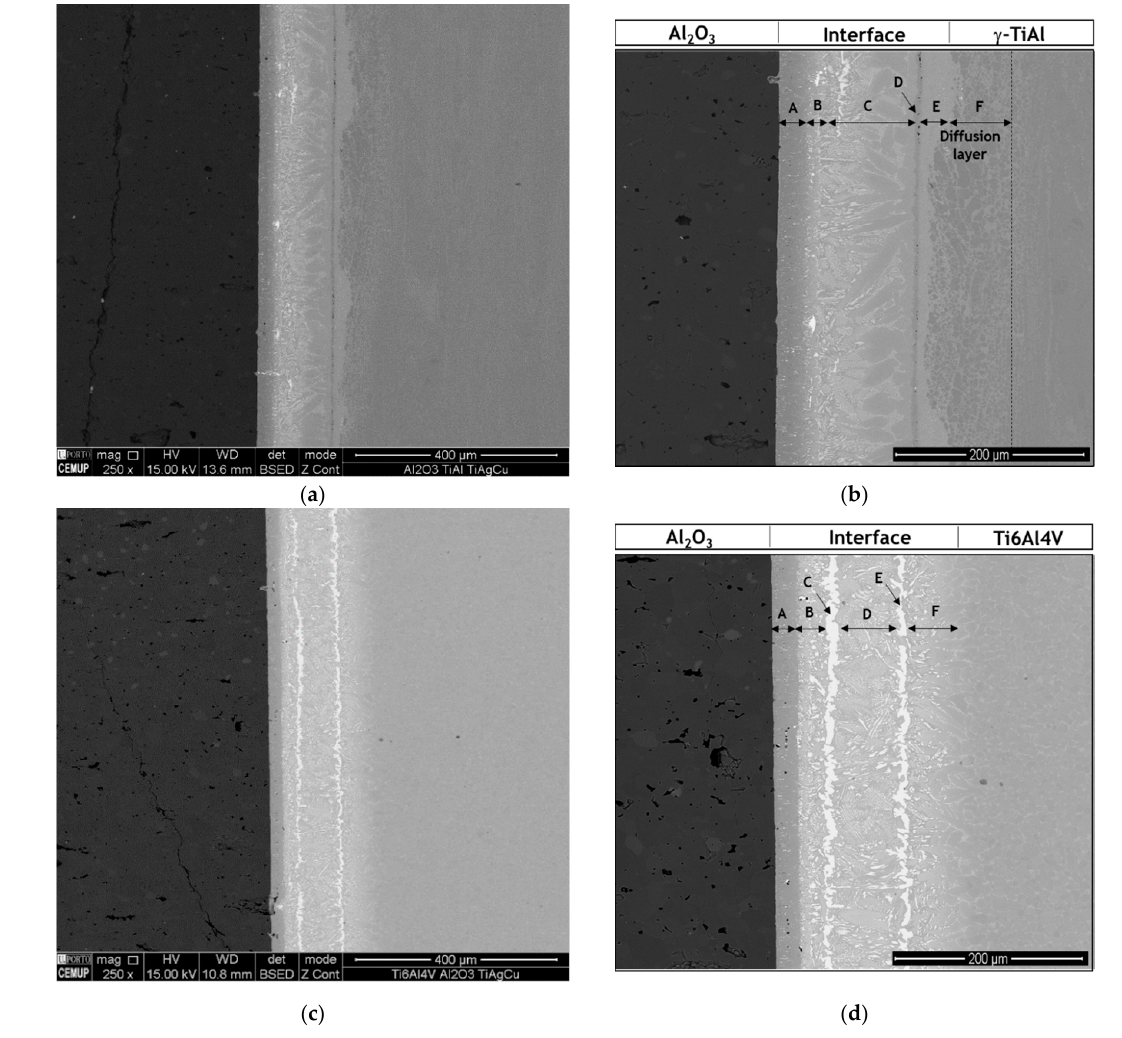
Figure 1. Scanning electron microscopy (SEM) images of the brazed interfaces of: ( a , b ) Al 2 O 3 / γ -TiAl alloy, and ( c , d ) Al 2 O 3 /Ti6Al4V joints, produced at 980 °C for 30 min. The Al 2 O 3 / γ -TiAl alloy interface can be divided into five different layers: a layer close to Al 2 O 3 (Layer A), a thin layer composed of a dark matrix with bright particles dispersed (Layer B), a central layer (Layer C), a dark thin layer (Layer D), a light-grey layer (Layer E) and a diffusion layer (Layer F).